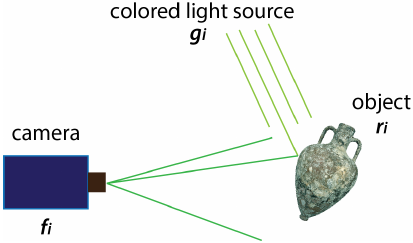
Figure 2: Underwater reflectance